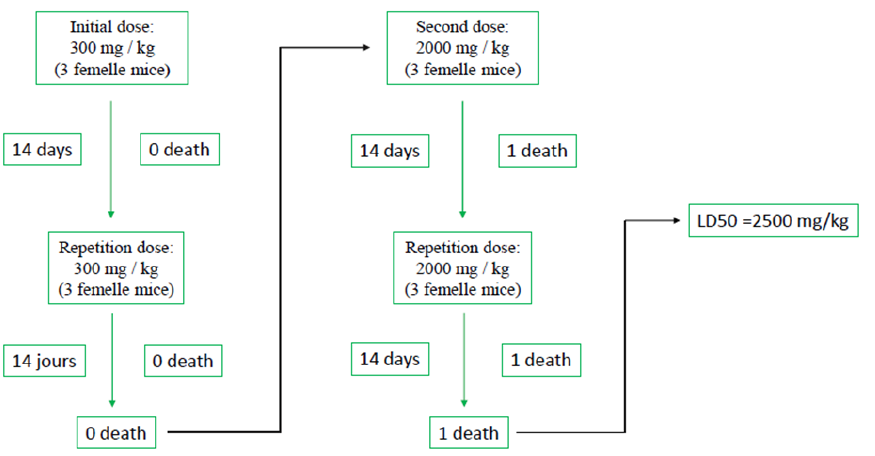
Figure 1. Determination of the LD 50 of Thymus leptobotrys Murb essential oil.